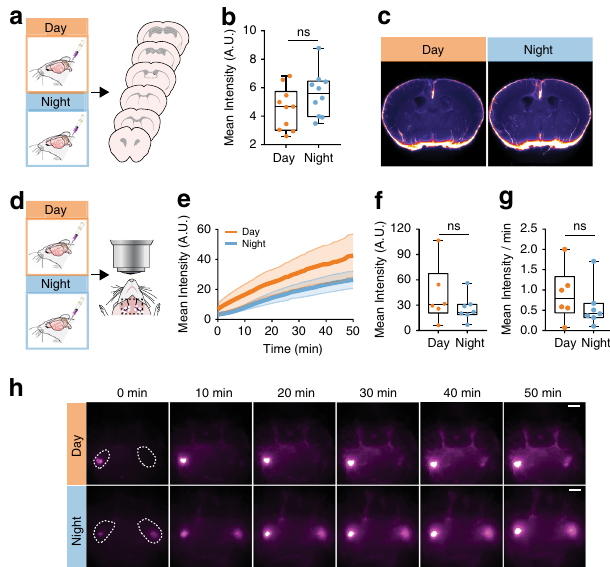
Fig. 6 AQP4 KO animals lack a rhythm in glymphatic in fl ux. a Experimental outline for b . b Boxplot of mean pixel intensity of slices from AQP4 KO animals during the day (orange) and night (blue). n = 10 mice per group. c Population-based averaging of slice intensity in AQP4 KO animals in the day and night. d Experimental outline. e Average fl uorescence over time, mean is the thick line, SEM indicated by shading. f Boxplot of fl uorescence in the lymph nodes at 50 min. g Boxplot of the rate of lymph vessel fi lling for the fi rst 20 min. h Time lapse imaging across 50 min in AQP4 KO mice during the day (orange, for d – h : n = 6 mice) and night (blue, for d – h : n = 7 mice). White scale bar: 2 mm. Time 0 on all graphs indicate start of imaging, on average 8 min after tracer infusion start. All boxplots: minima is minimum value, maxima is maximum value, center is median and quartiles shown by box and whiskers, with individual animals shown as colored dots. ns: not signi fi cant. Source data are provided as a Source Data fi